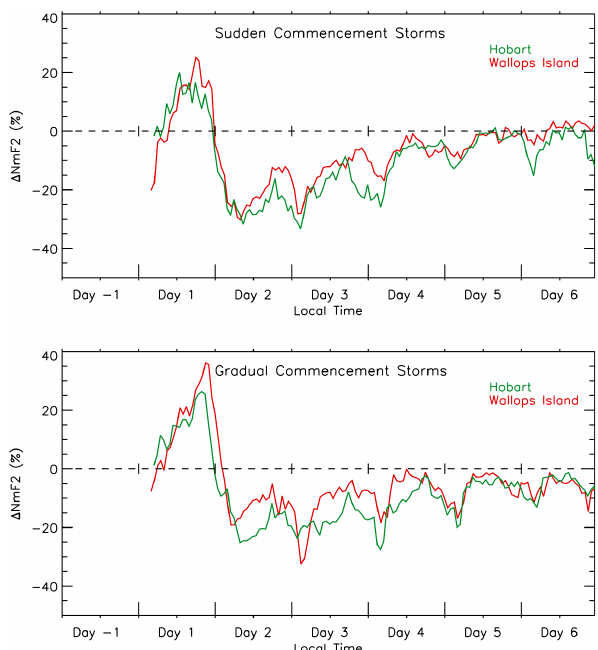
Fig. 6. Results following the same methods shown in Fig. 5, but with subsets of the 206 storms that had sudden storm commence- ments (96 SSCs) versus the pattern resulting from the 110 gradual storm commencements (GSCs). Uncertainties, as portrayed by er- rors of the mean, in this and all subsequent figures are comparable as those shown in Fig. 5, but are not shown for clarity of the curves